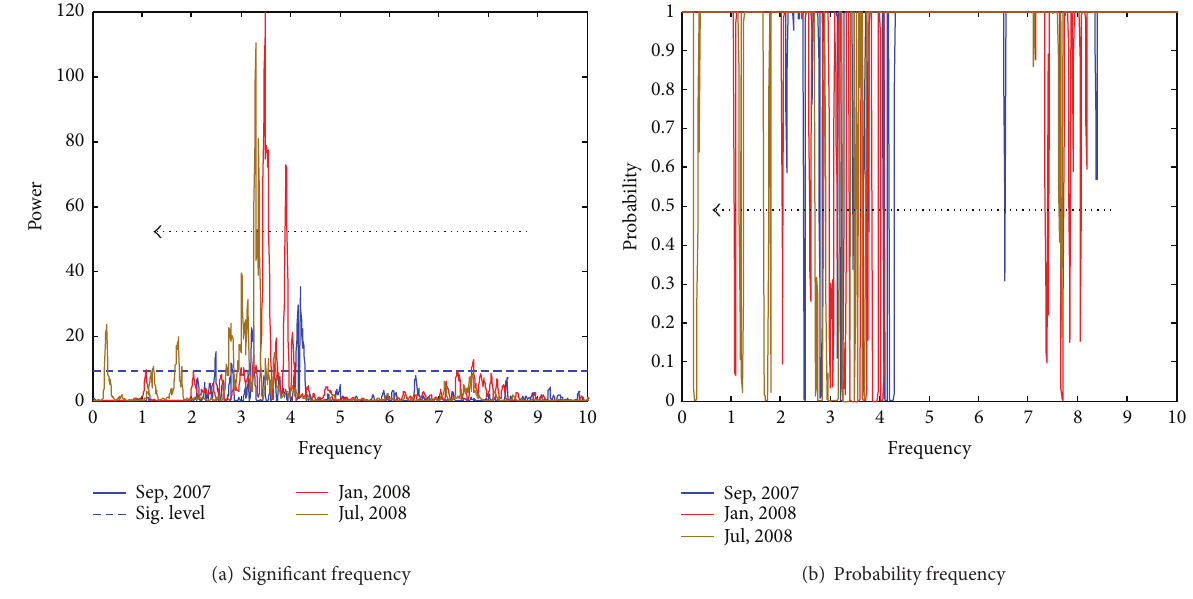
Figure 9: Significant and probability frequency changes.